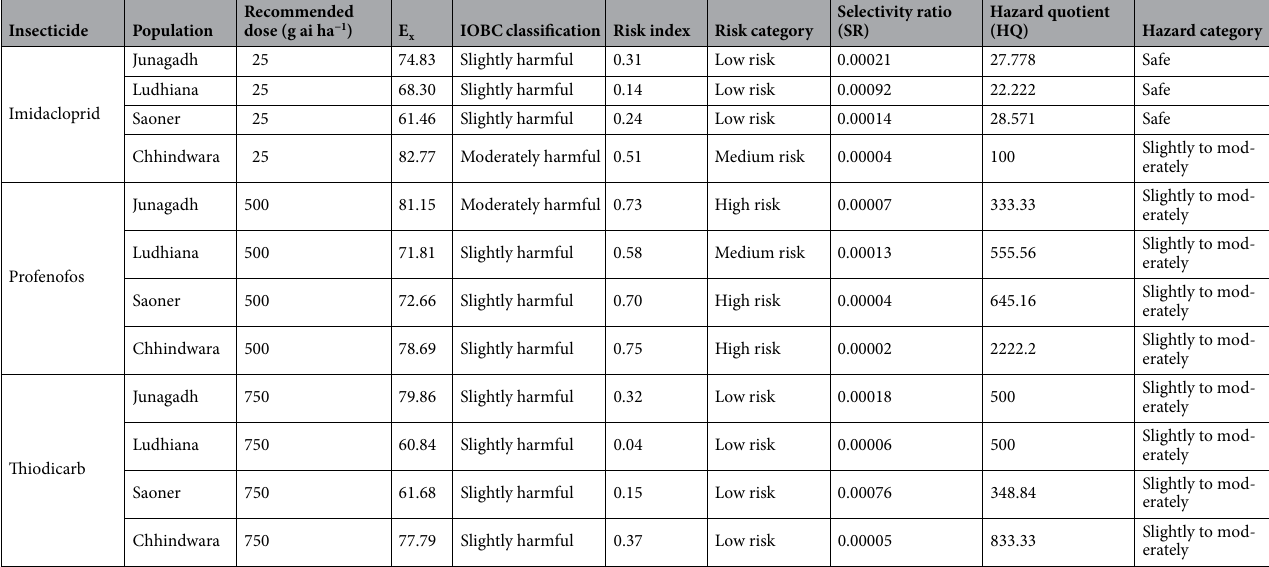
Table 5. Environmental Risk Assessment (ERA) parameters estimated for field populations of Aenasius arizonensis . ERA parameters were estimated on the females of Aenasius arizonensis exposed to lethal doses of imidacloprid, profenofos and thiodicarb. E x denotes Reduction coefficient. IOBC classification is based on Reduction coefficient values. Risk category: categorizing of insecticides based on Risk Indices in 0–1 scale with 0 = safe and 1 = Highly risk. Selectivity ratio (SR)values < 1 indicates the non selective nature of the insecticides; Hazard category : If HQ is less than 50—a pesticide is considered safe, 50–2500—slightly to moderately toxic and > 2500 as